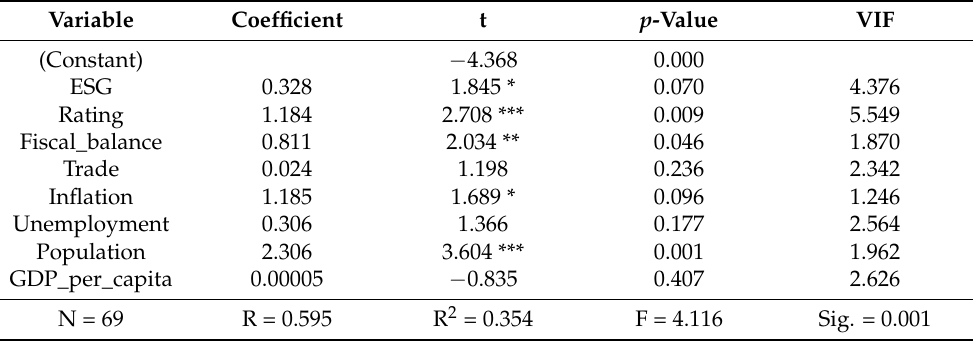
Table 5. Regression